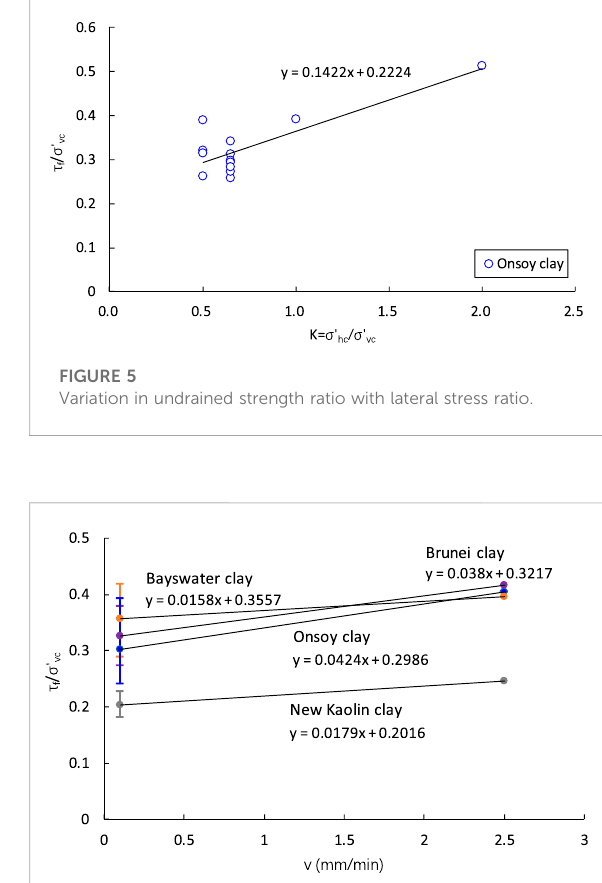
FIGURE 3 Variation in undrained strength ratio with excess pore pressure ratio at failure.